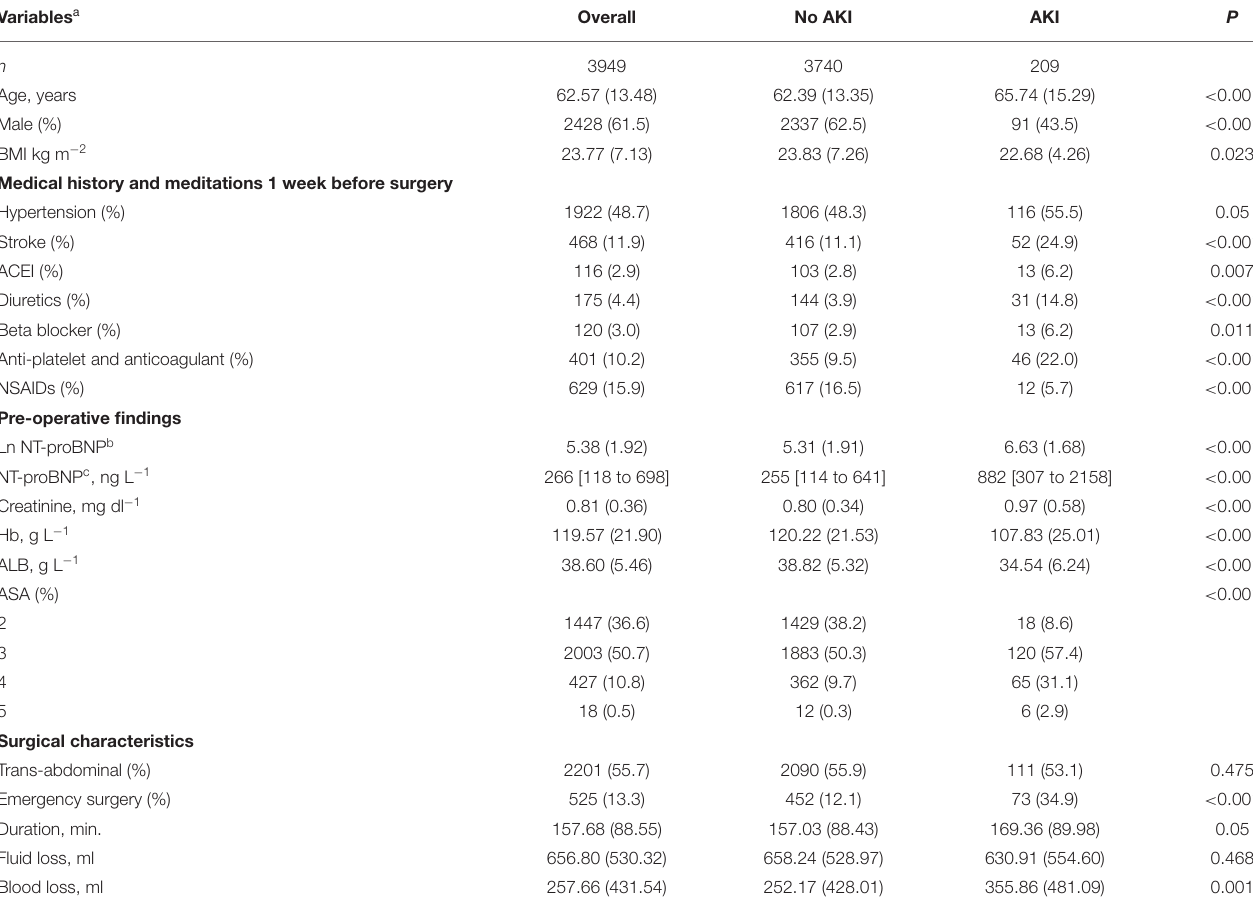
TABLE 1 | Baseline characteristics of the